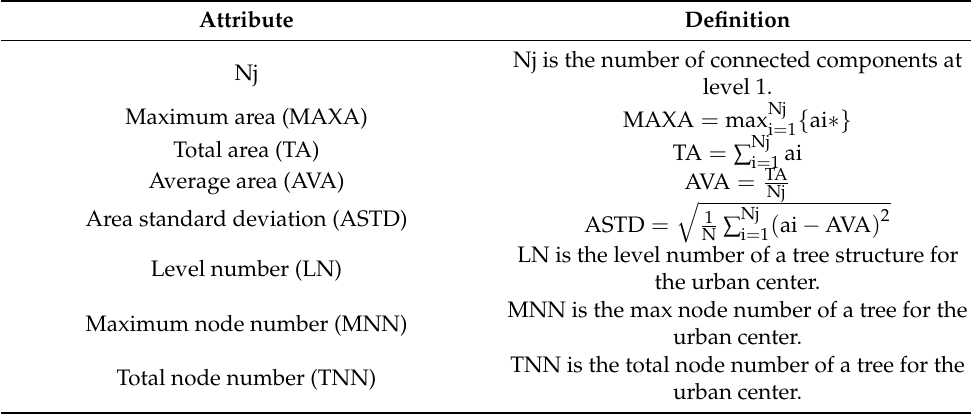
Table 2. City analysis parameter